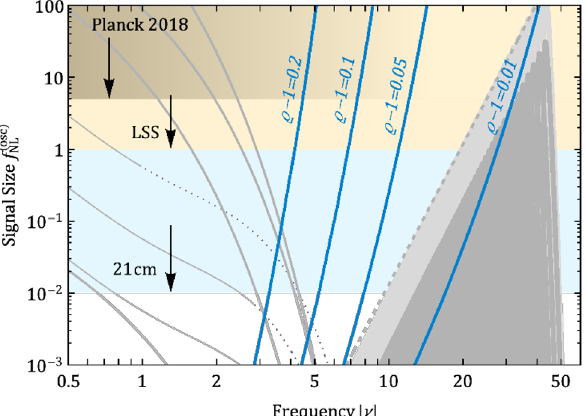
Figure 2 . The same signals as in figure 1 plotted as functions of oscillation frequency ν = e p ( m A /H ) 2 − 1 / 4 for several choices of % ’ µ/m A (blue curves), together with signals from other scenarios adapted from figure 1 in [21], and rough reaches of current and future observations. The light gray contours are the predictions of the quasi-single-field inflation scenario and several other scenarios, and the light gray shaded region on the right is the signal of the models in which the inflaton has a coupling to the chiral current of massive fermions. Note that the gauge boson signals & 0 . 1 ) not populated by previously known could show up in a parameter region ( 4 . ν . 20 , f (osc) e NL scenarios. In the plot we take u = 1 as in figure 1. See section 5 for more discussions about this